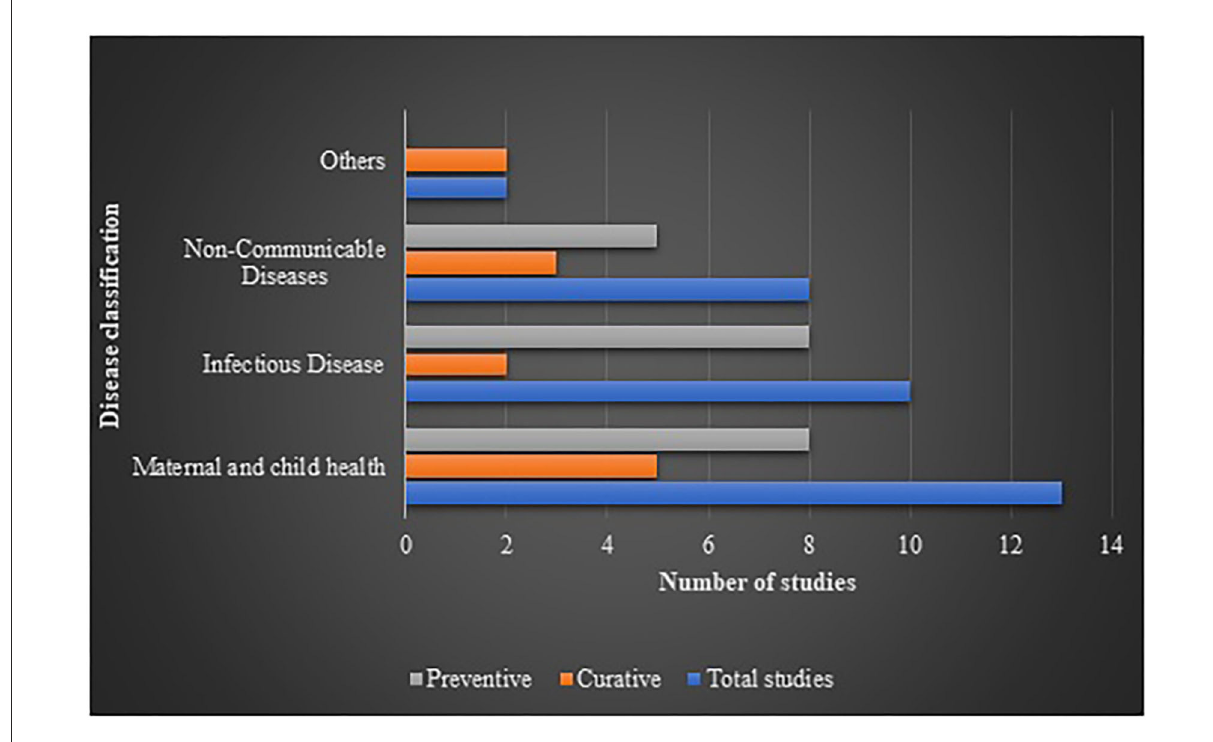
FIGURE2 Number of HTA studies classified as per disease and nature of